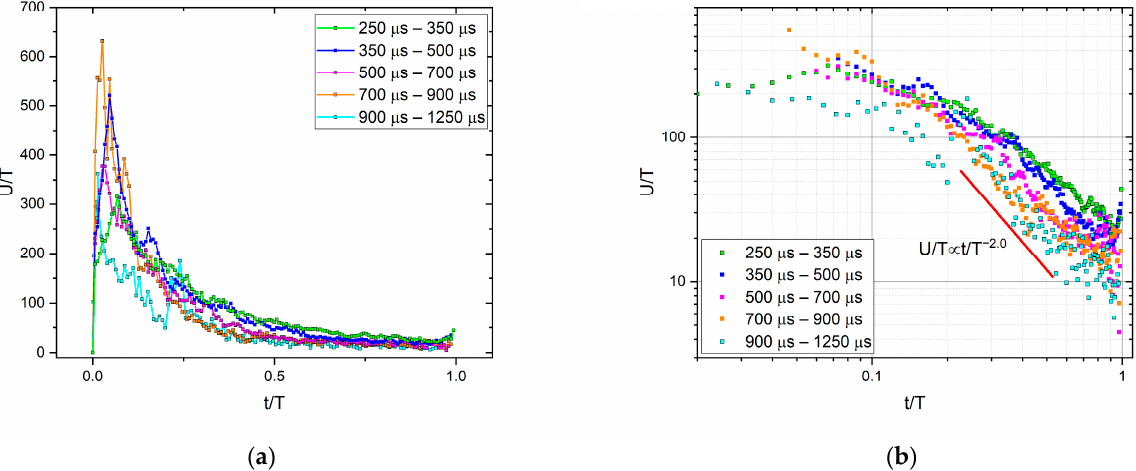
Figure 6. ( a ): Average temporal shapes of AE avalanches for various fixed duration ranges. 𝑈/𝑇 vs. 𝑡/𝑇 . ( b ): Fitting of the decaying tail of curves of ( a ).